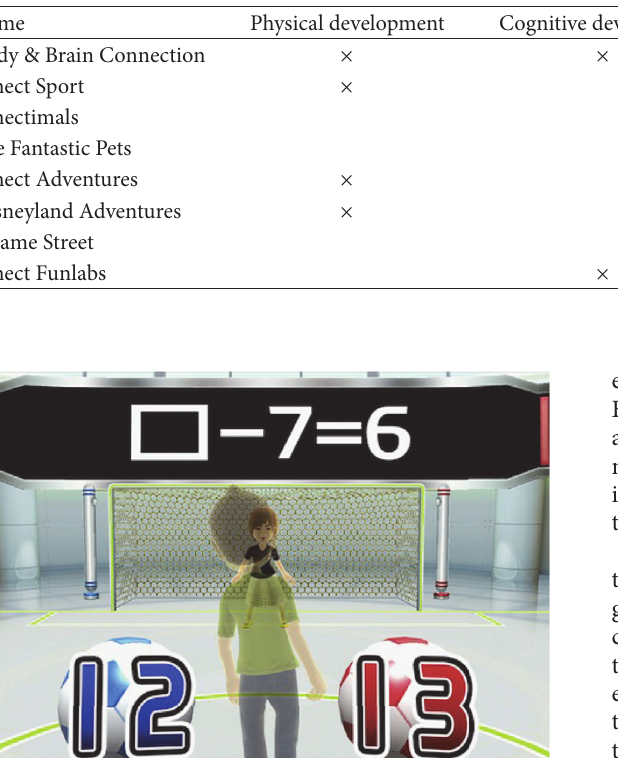
Table 1: Categorization of Kinect games’ utilization for educational purposes in various developmental axes.